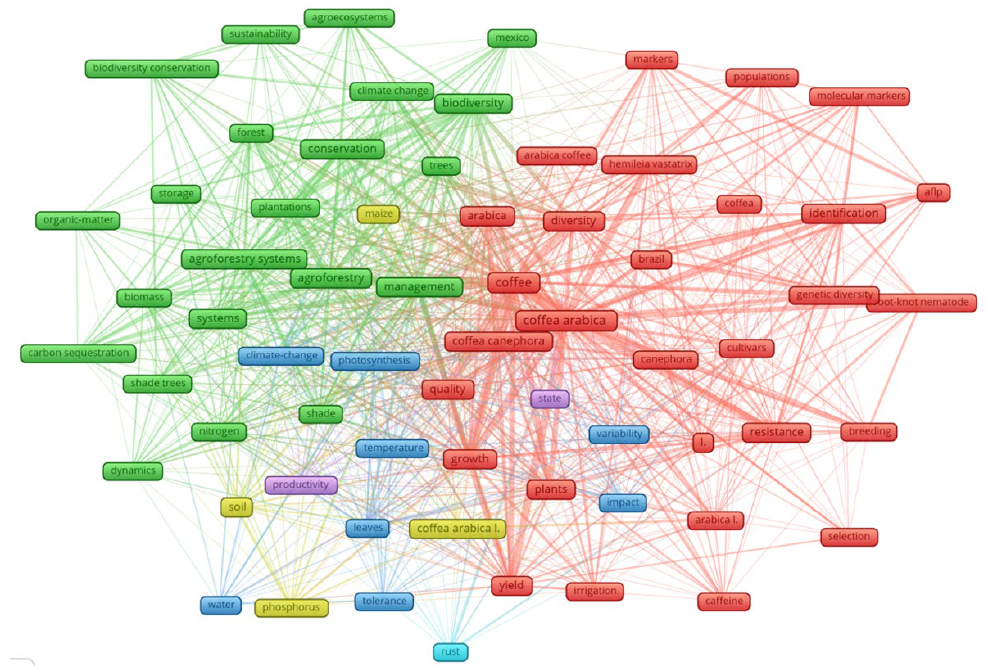
Figure 8. Coffee agronomy research keywords co-occurrence network, thematic visualization.